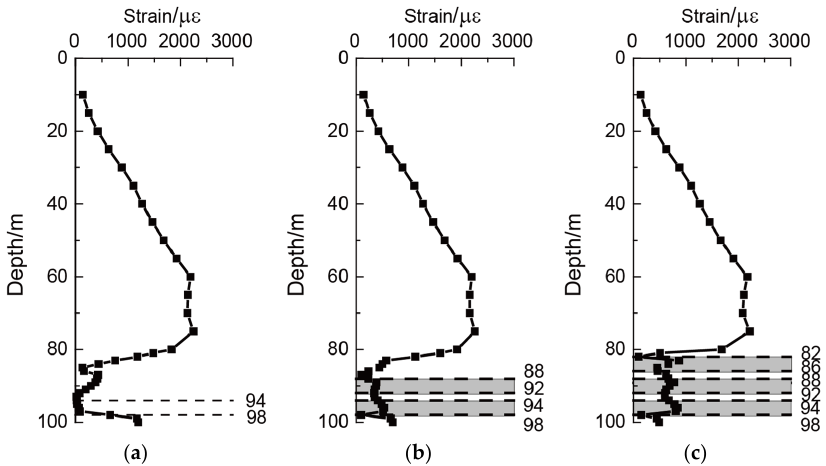
Figure 8. Results of the rock-socketed piles with different numbers of karst caves. ( a ) Single-beaded karst cave, ( b ) double-beaded karst cave, and ( c ) three-beaded karst cave.